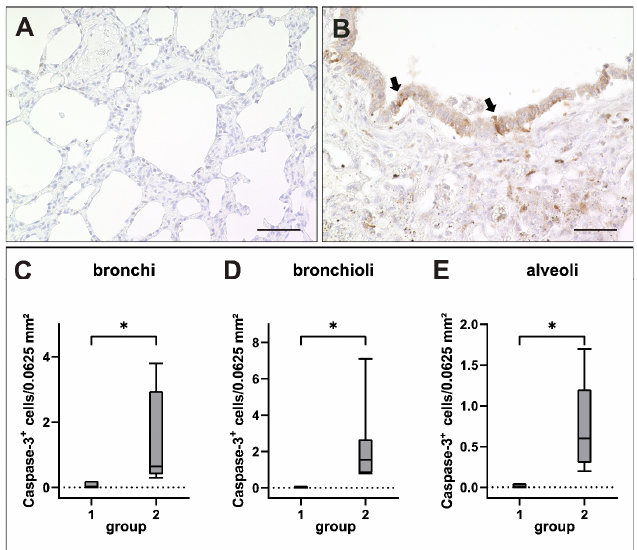
Figure 10. Apoptosis in canine distemper virus (CDV)-infected lungs. ( A ) Non-infected control lung. ( B ) Lung of a dog with CDV infection with CC-3 + apoptotic cells within the bronchiolar epithelium (arrows). ( C – E ) Increased numbers of apoptotic cells in bronchi ( C ), bronchioli ( D ) and alveoli ( E ) of infected dogs. Groups: 1 = non-infected control lung; 2 = acute CDV infection; box and whisker plots display median and quartiles with maximum and minimum values. Significant differences ( p ≤ 0.05, Kruskal–Wallis H test) are labeled by asterisks. Scale bars: ( A , B ): 50 µ m.